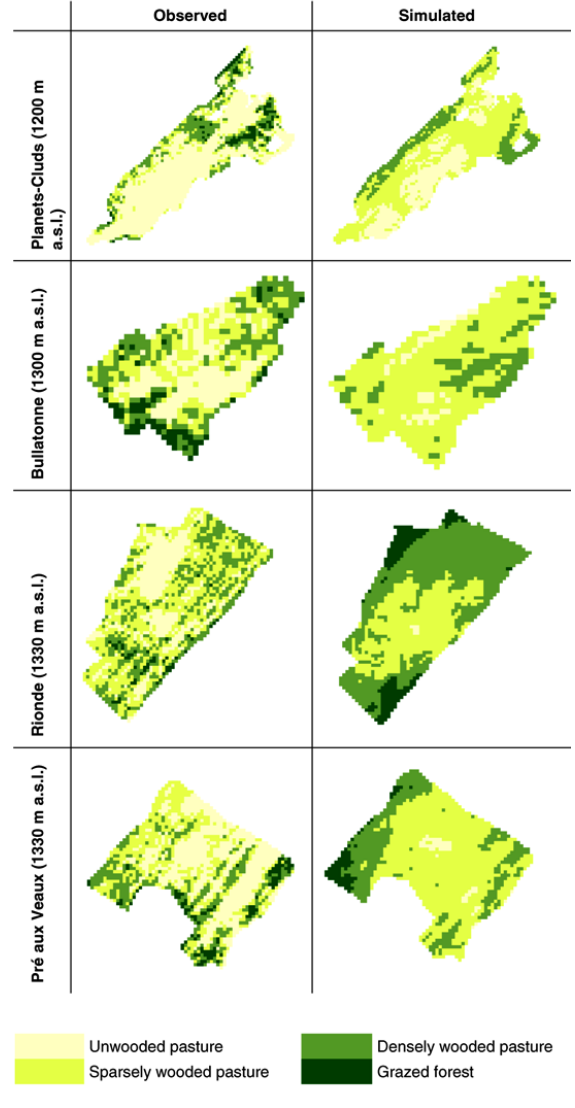
Fig. 4 . Long-term historical simulations (1100 AD–2000 AD) and observed (2000 AD) landscape mosaics in the four pastures Planets-Cluds, Bullatone, Rionde, and Pré aux Veaux (m a.s.l. = meters above sea level). Squares represent 25-m grid cells used for both photo interpretation and model simulation. The four phytocoenosis types used for display are defined in Table 3.